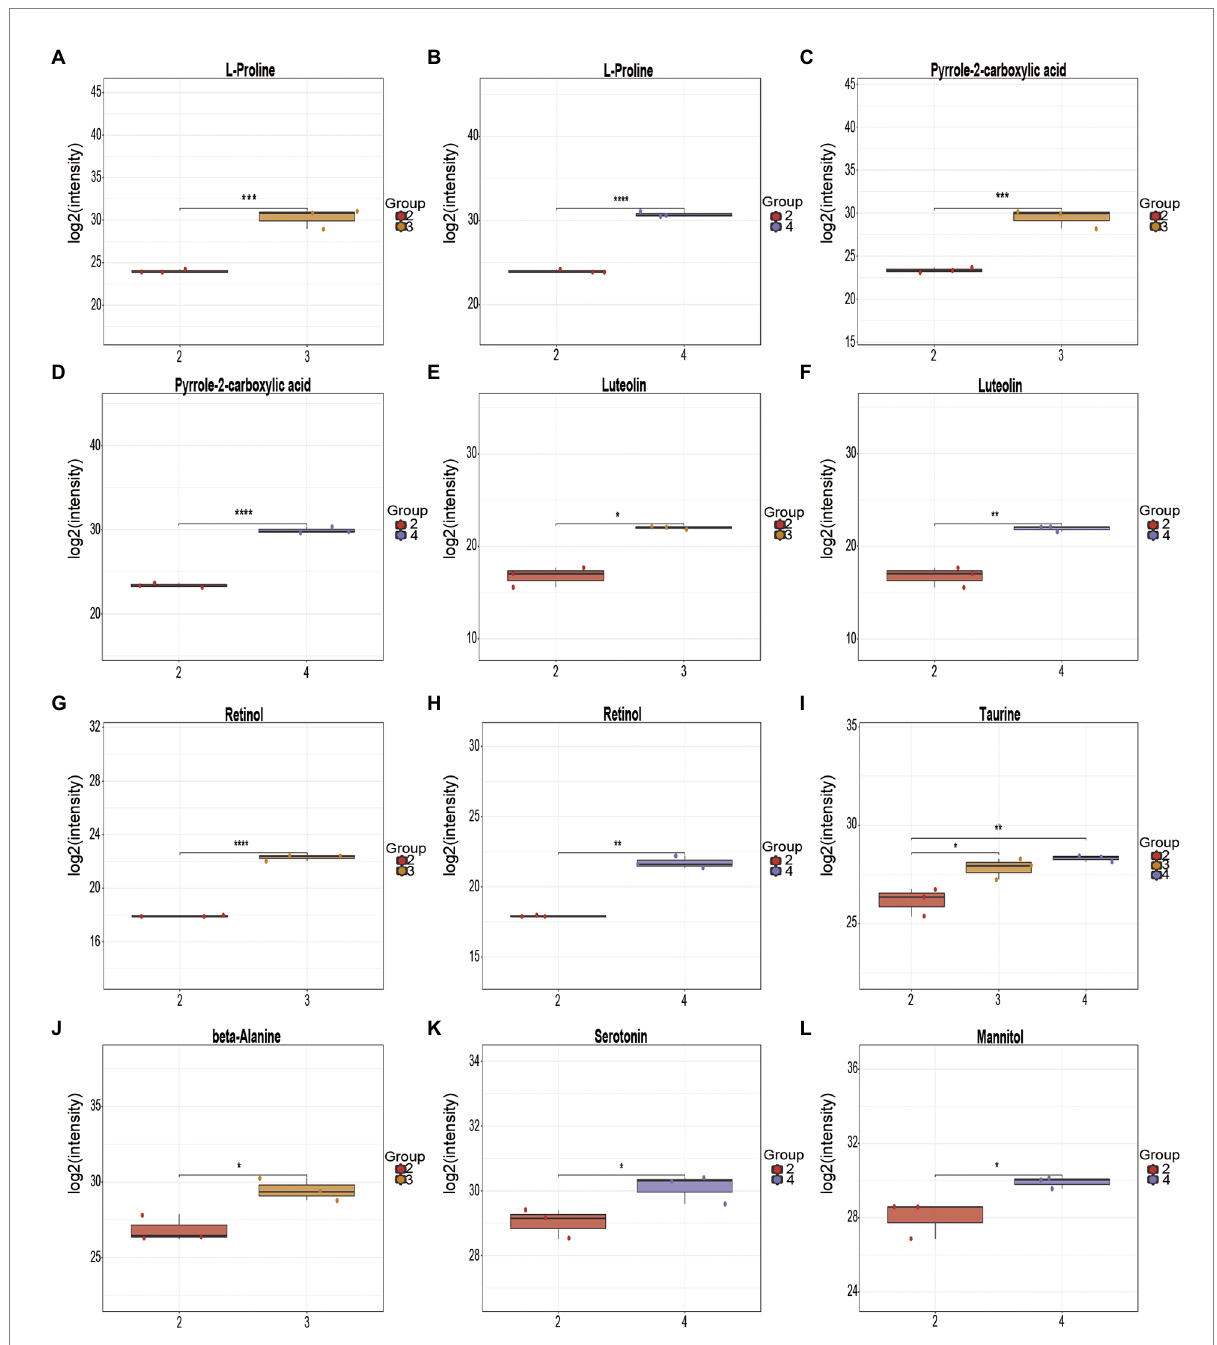
FIGURE 6 Box plot of differential metabolite changes before and after fermentation. Changes in L-proline after (A) Lactobacillus plantarum R9 and (B) Lactobacillus gasseri B1-27 fermentation. (C) Changes in pyrrole-2-carboxylic acid after fermentation (C) L. plantarum R9 and (D) L. gasseri B1-27 fermentation. Changes in luteolin after (E) L. plantarum R9 and (F) L. gasseri B1-27 fermentation. Changes in retinol (G) L. plantarum R9 and (H) L. gasseri B1-27 fermentation. (I) Changes in taurine after L. plantarum R9 and L. gasseri B1-27 fermentation. (J) Changes in beta-alanine after L. plantarum R9 fermentation. (K) Changes in serotonin after L. gasseri B1-27 fermentation. (L) Changes in mannitol after L. gasseri B1-27